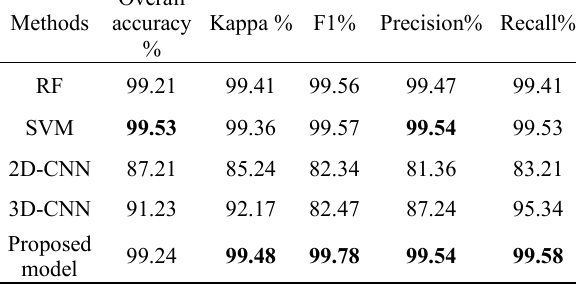
Table 1 . Comparison Accuracy on Chikusei data with another state-of-the-art method. The bold values denote the best result.